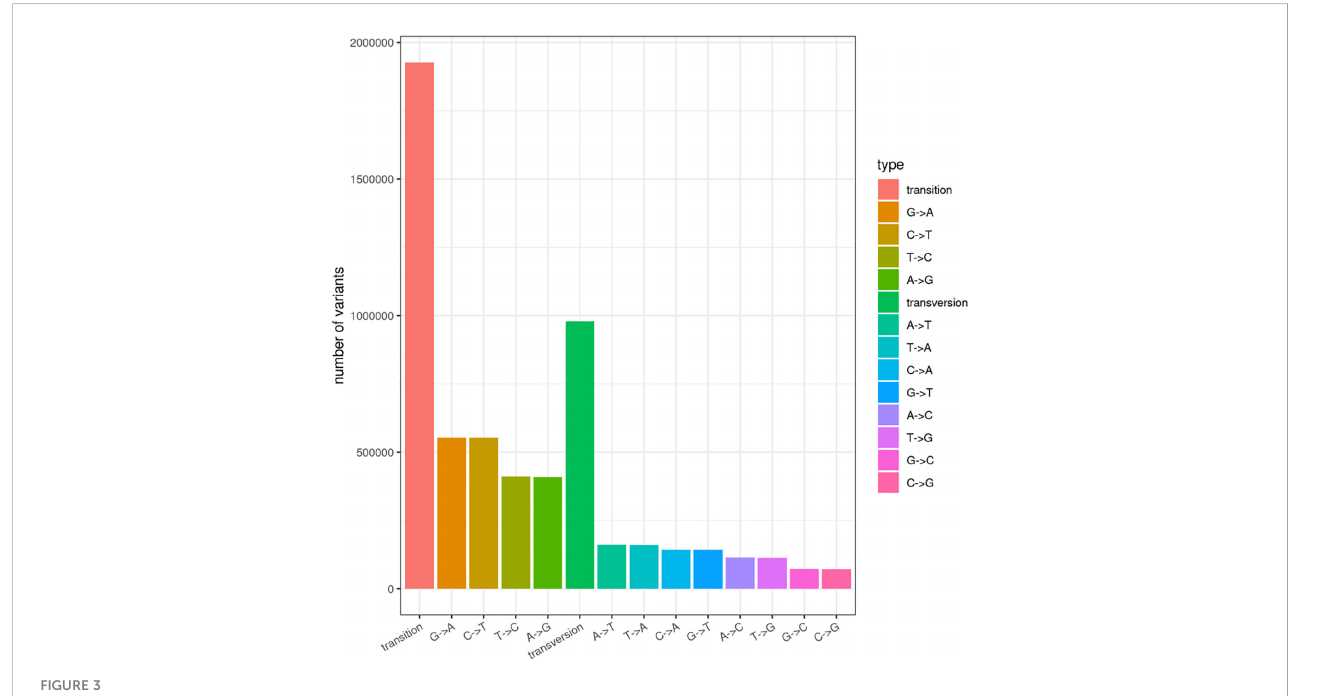
FIGURE 3 Statistic number of each SNP type.